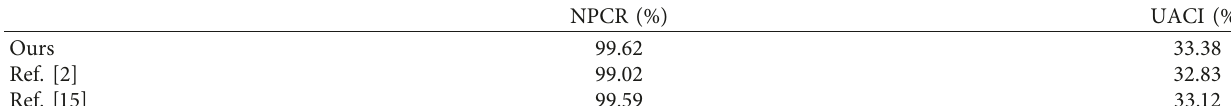
Table 3: Comparison of NPCR and UACI in this paper and other